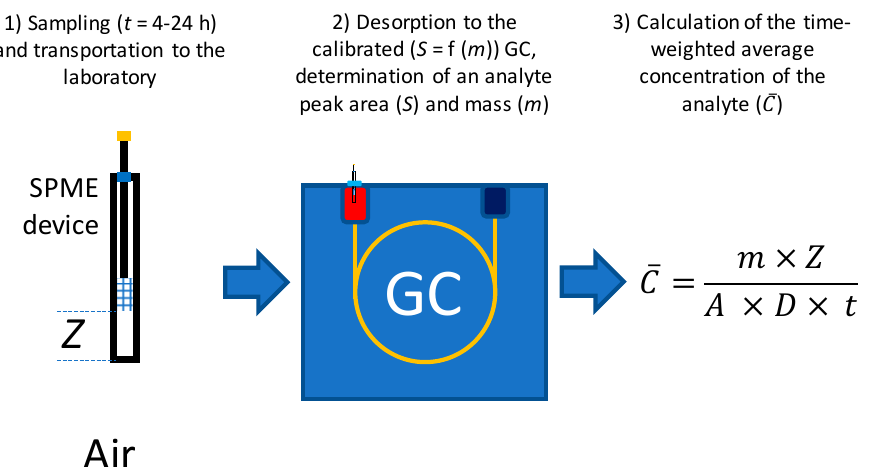
Figure 1. The typical procedure of time-weighted average sampling and analysis using retracted solid-phase microextraction fiber.